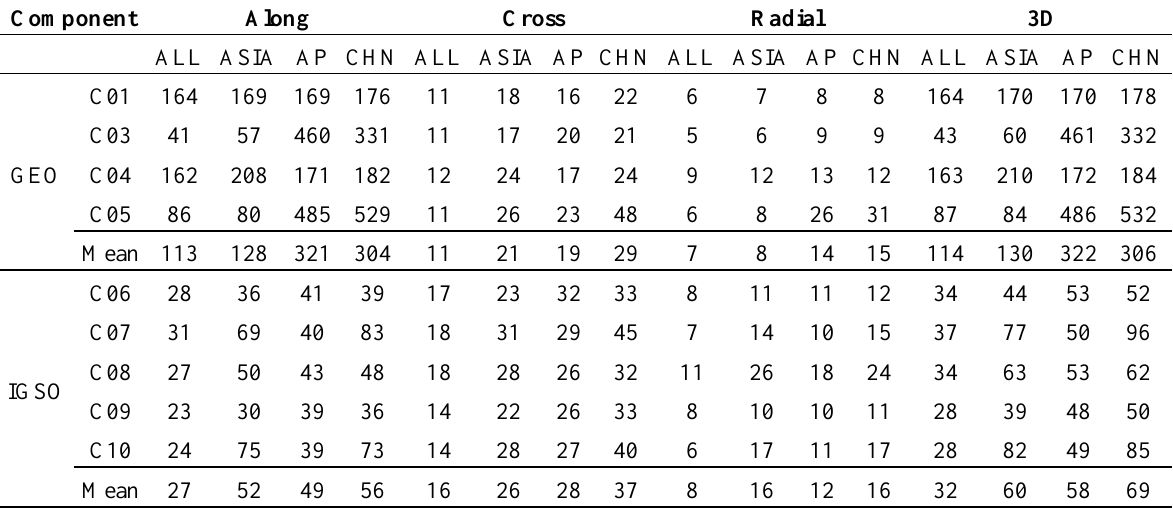
Table 6. Orbit RMS [cm] comparison for four networks: Chinese regional network (CHN), Asian-Pacific network (AP), Asian network (ASIA), and global network (ALL). Component Along Cross Radial